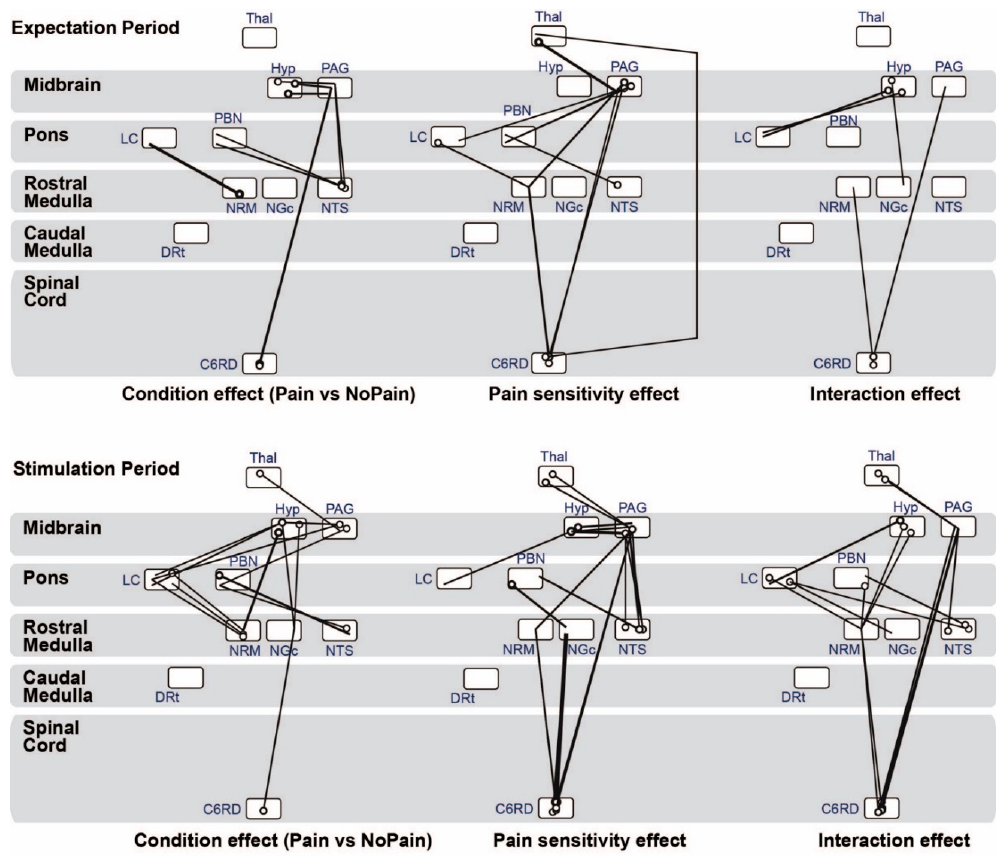
Figure 4. Results of ANCOVA analysis of significant β -values for the ‘expectation’ time period (upper row, after participants knew whether or not to expect pain, but before a stimulus was applied) and ‘stimulation’ time period (lower row, while participants were either experiencing pain or no stimulus). Pictured from left to right are the connections with a significant main e ff ect of condition (‘pain’, where a stimulus would be applied, and ‘no pain’, where no stimulus would be applied), a significant main e ff ect of individual pain sensitivity, and significant condition × sensitivity interaction e ff ects. Significant connections are shown at a false-discovery-rate corrected p FDR < 0.05. Lines represent significant connections, circles represent the connection’s source, and the line end represents the target region. Rectangular bubbles represent anatomical regions, and the space inside the bubble is divided into the region’s di ff erent clusters. Only the C6RD segment of the spinal cord is used as being representative of brainstem-cord connectivity, because it corresponds to the heat stimulus applied to the hand.